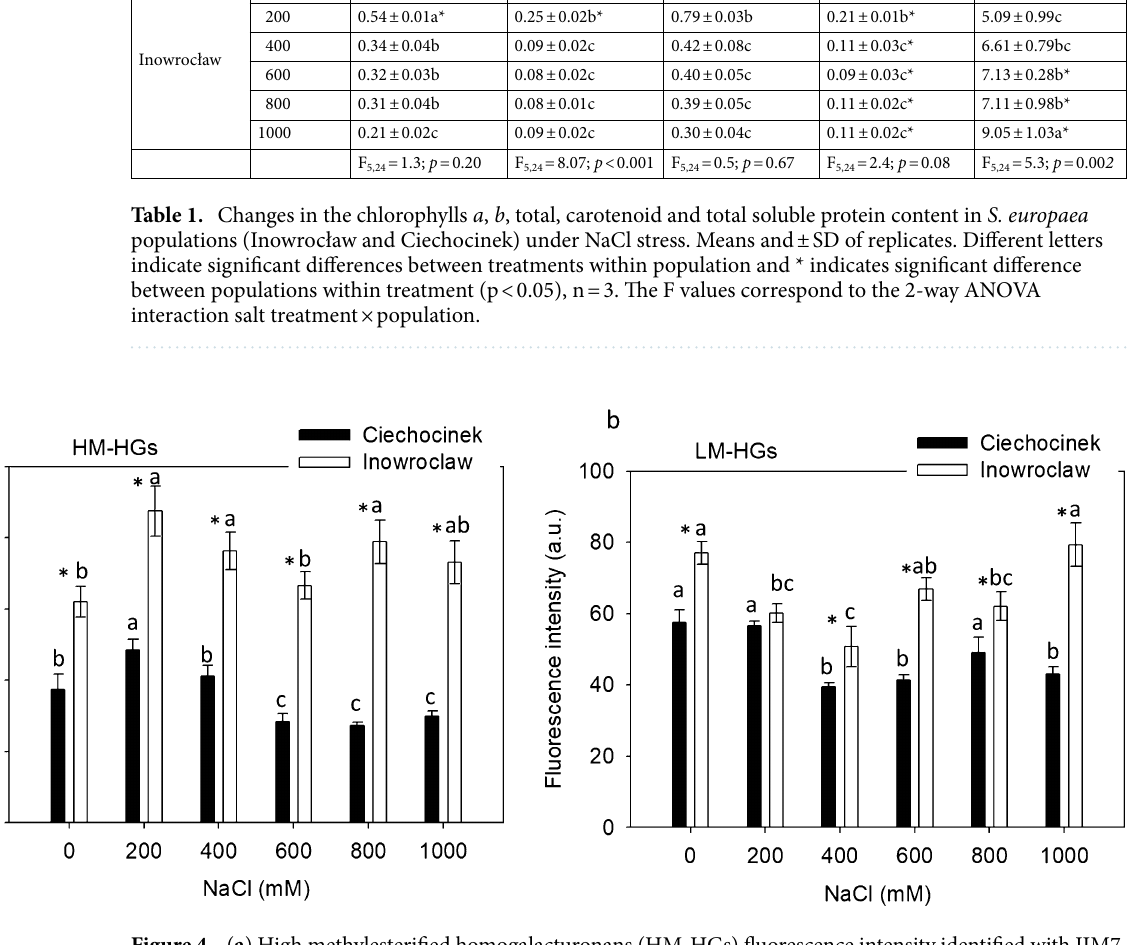
Figure 4. ( a ) High methylesterified homogalacturonans (HM-HGs) fluorescence intensity identified with JIM7 antibody; and ( b ) Low methylesterified fluorescence (LM-HGs) identified with LM19 antibody, in S . europaea stem cross-sections of Ciechocinek and Inowrocław populations subjected to 6 salinity treatments. Means and ± SD of replicates. Different letters indicate significant differences between treatments within population and * indicates significant difference between populations within treatment (p < 0.05), n = 3. The F values that correspond to the 2-way ANOVA for the interaction salt treatment × population are F 5,48 = 3.6, p = 0.007 and F 5,48 = 4.5, p = 0.002 for HM-HGs and LM-HGs